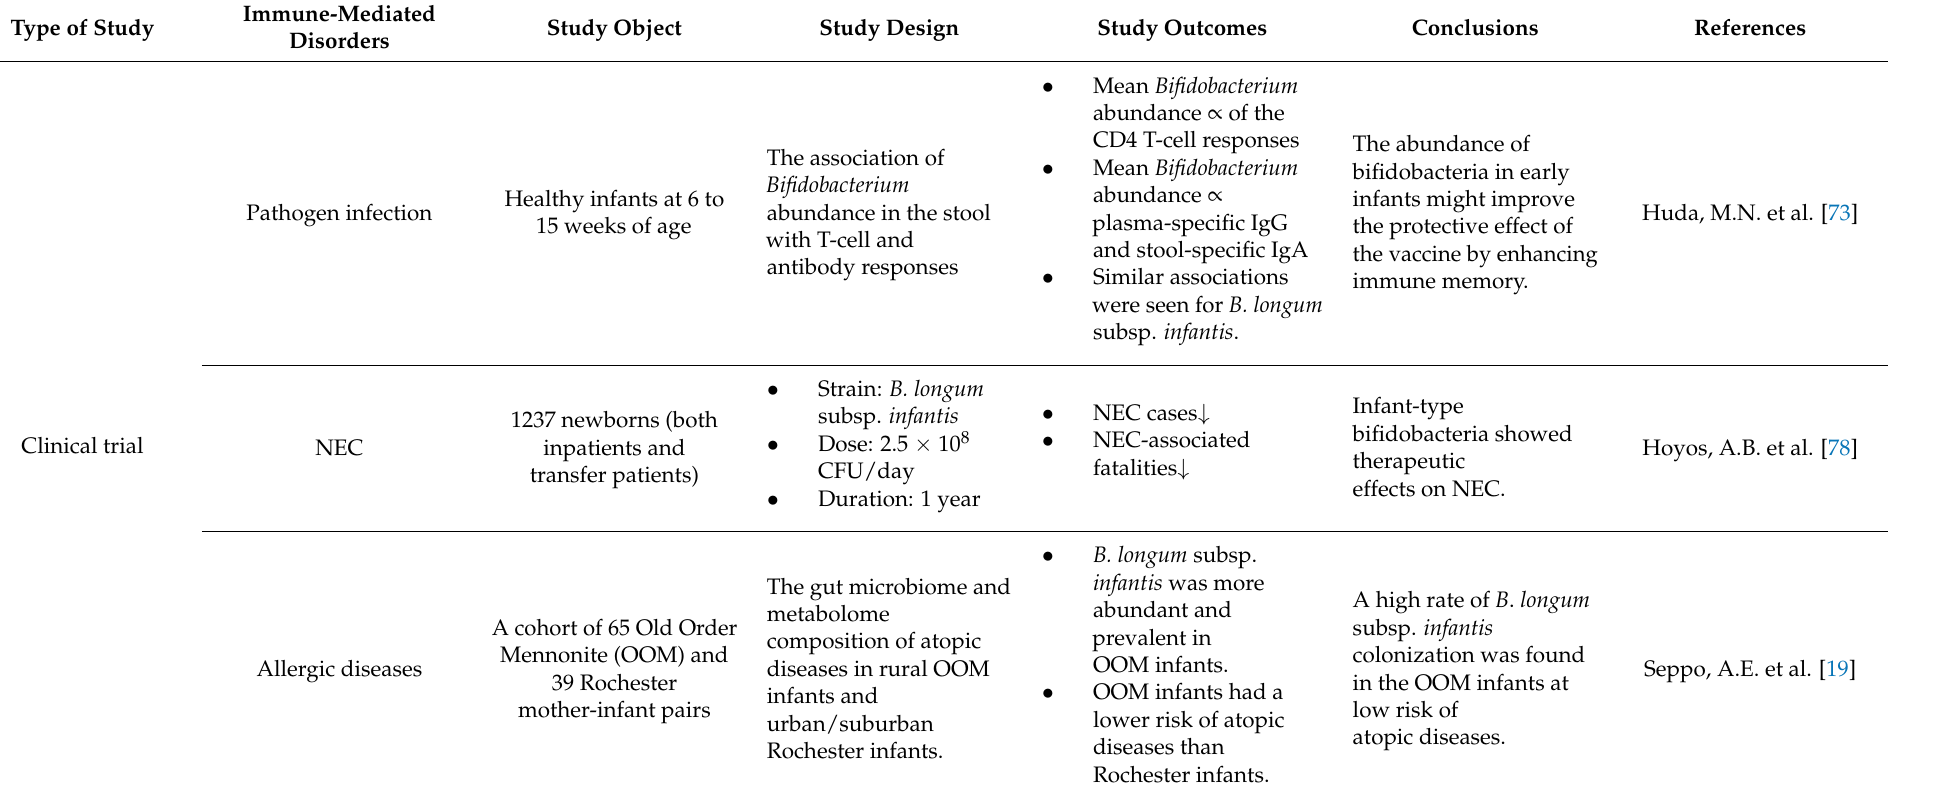
Table 1. Summary of studies engaging specific strains of ‘infant-type’ bifidobacteria for the treatment of immune-mediated